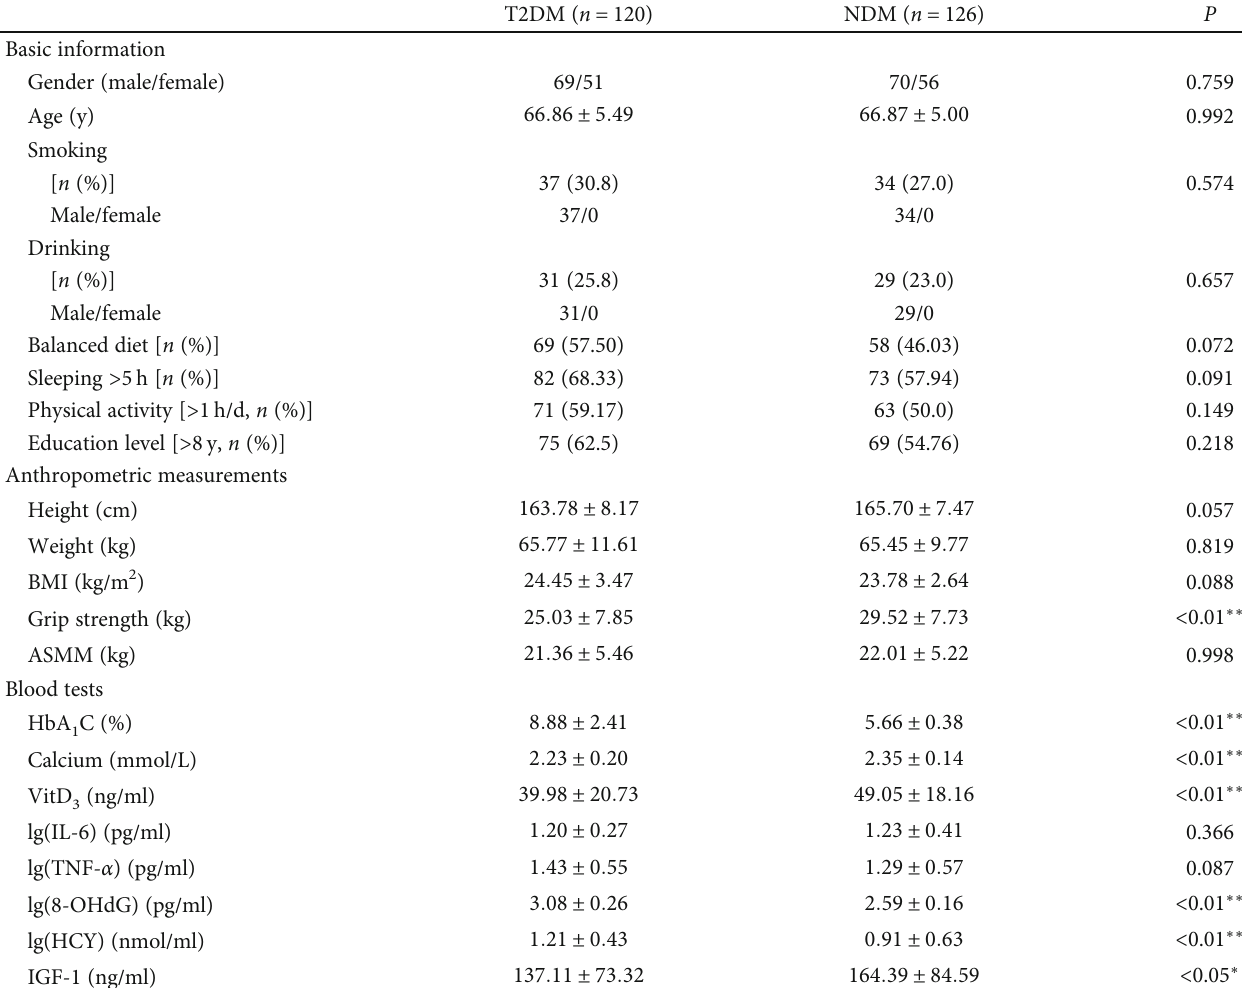
Table 1: The basic information of the subjects (mean ± SD or